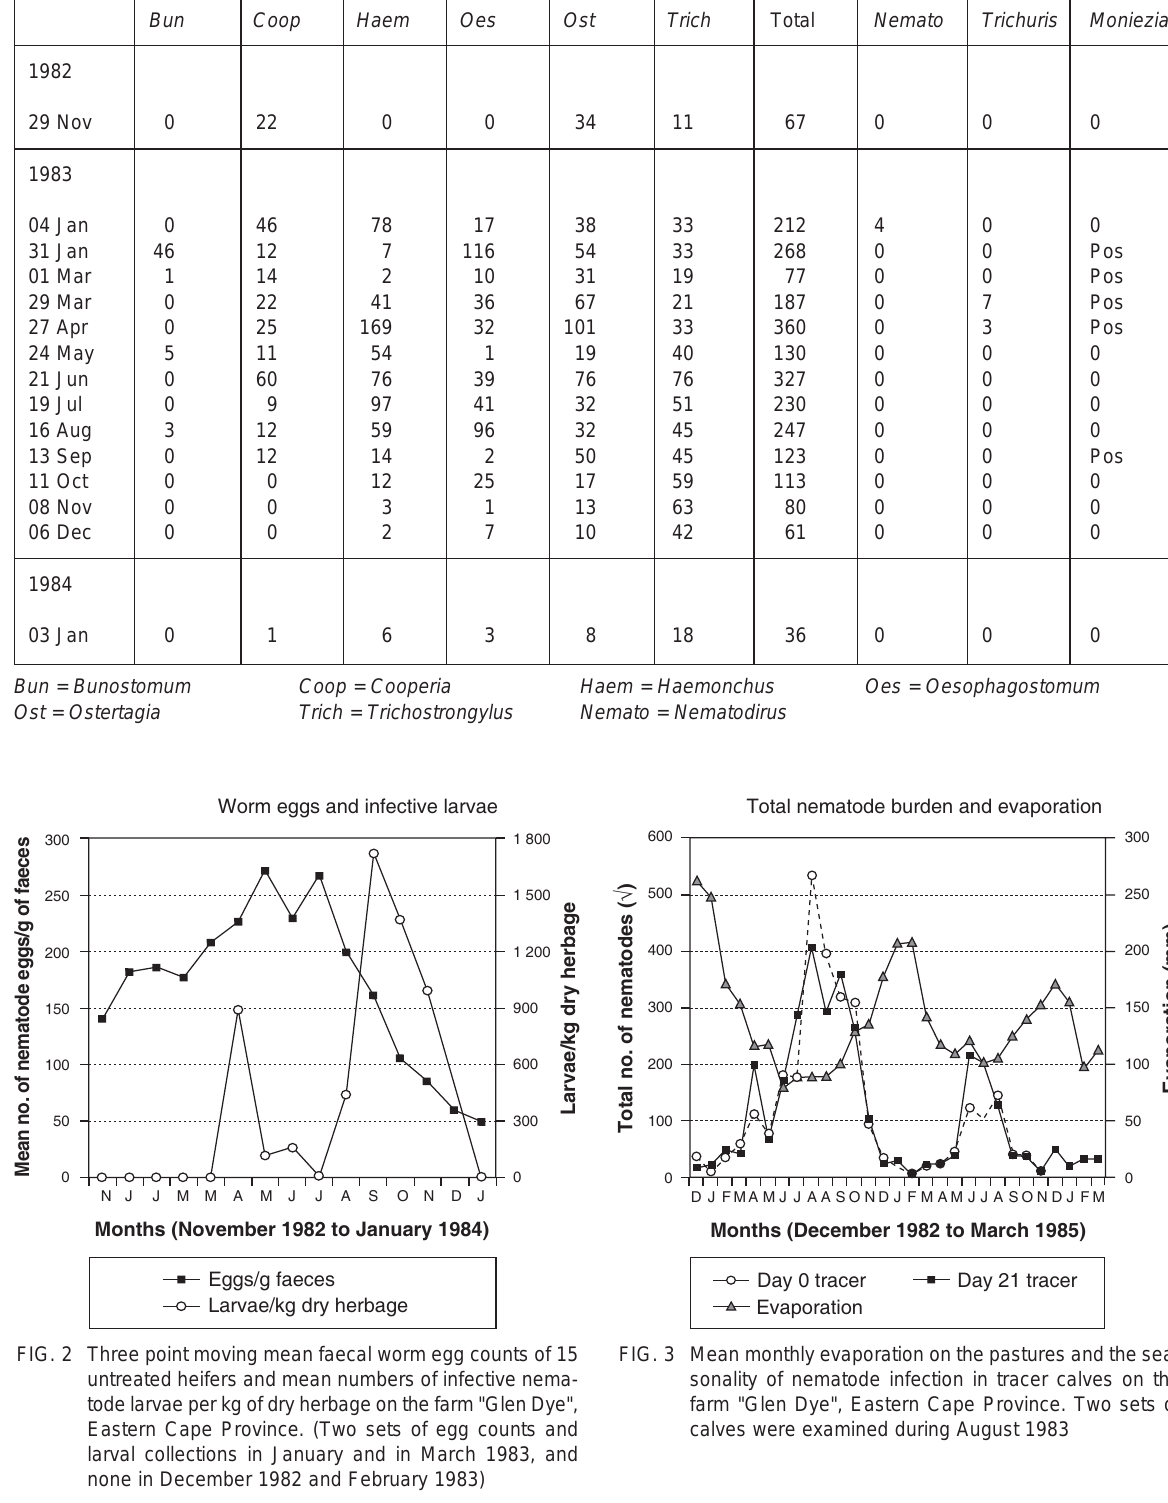
TABLE 1 Differential faecal worm egg counts of 15 Friesland heifers on Kikuyu grass pastures on the farm “Glen Dye”, Eastern Cape Province Average number of eggs per g of faeces calculated from larvae Eggs only identified during faecal recovered in faecal cultures worm egg counts Date Bun Haem Trichuris